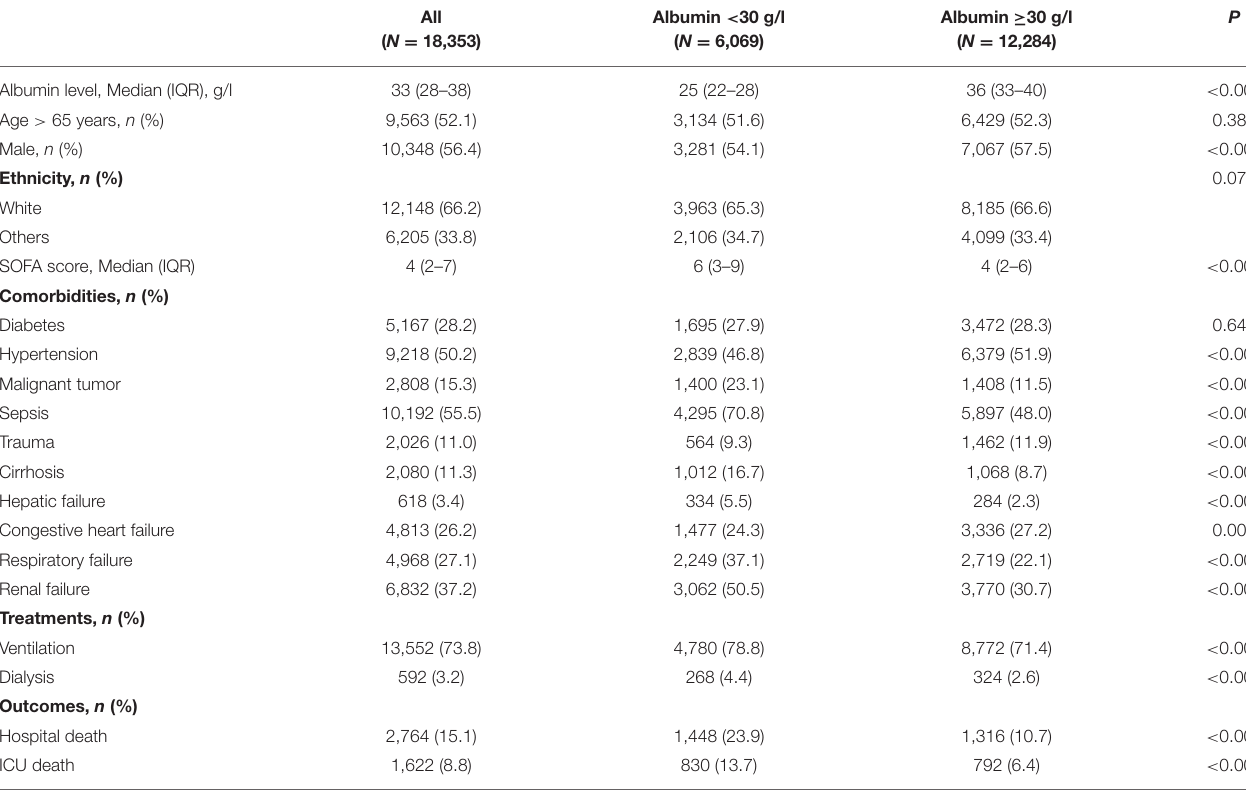
TABLE 1 | Demographic and clinical characteristics at baseline for patients from Medical Information Mart for Intensive Care IV